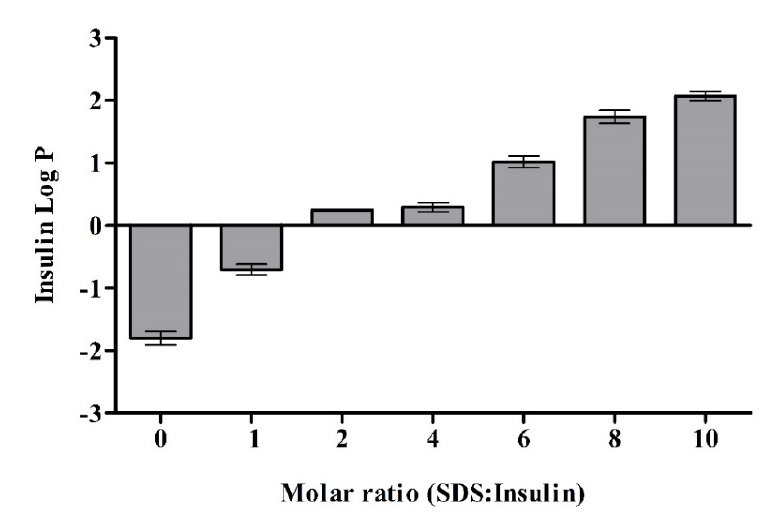
Figure 2. Log P octanol/water of INS with indicated molar ratios of sodium dodecyl sulfate (SDS). INS and INS-SDS complexes were incubated in octanol/water (1:1) at 37 °C, 500 rpm for 12 h. Octanol and water phases were separated by centrifugation, and INS was quantified in each phase via HPLC. Data are shown as means ± SD ( n = 3).